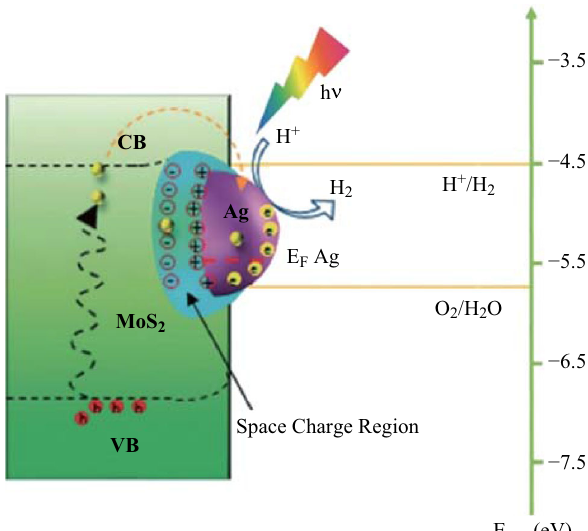
Fig. 11 Illustration of heterojunction between a 2D MoS 2 nanosheet and an Ag nanoparticle. Reproduced with permission of Ref.